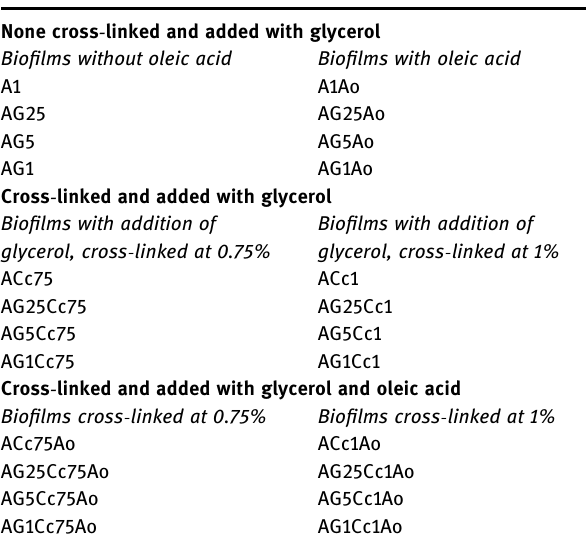
Table 1: Bio fi lm formulation 1% ( % w/v ) sodium alginate ( A1 )